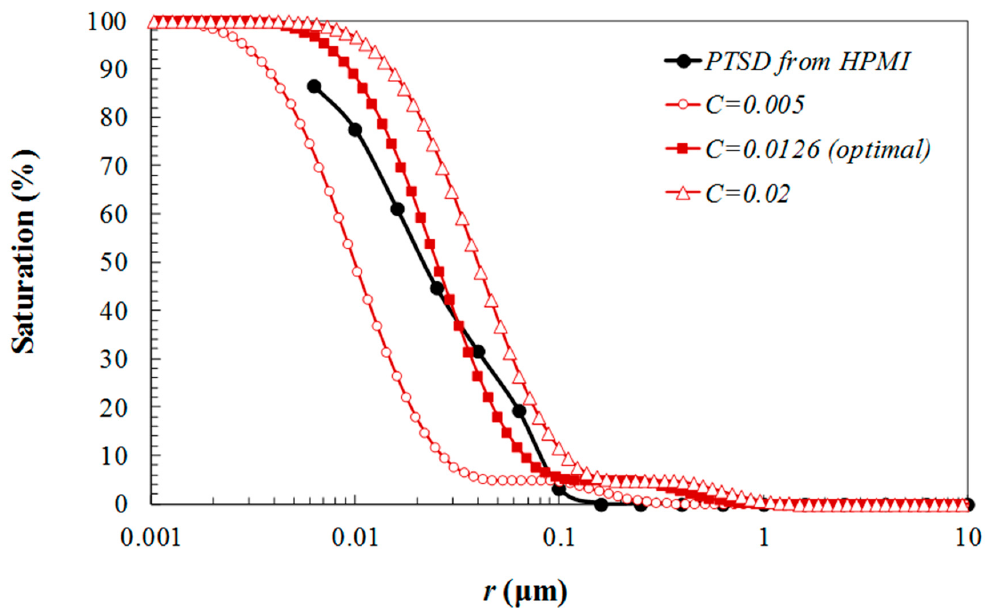
Figure 6. Comparison between the measured PTSD from HPMI and the converted PTSD from NMR with different linear conversion coefficient for Z39.